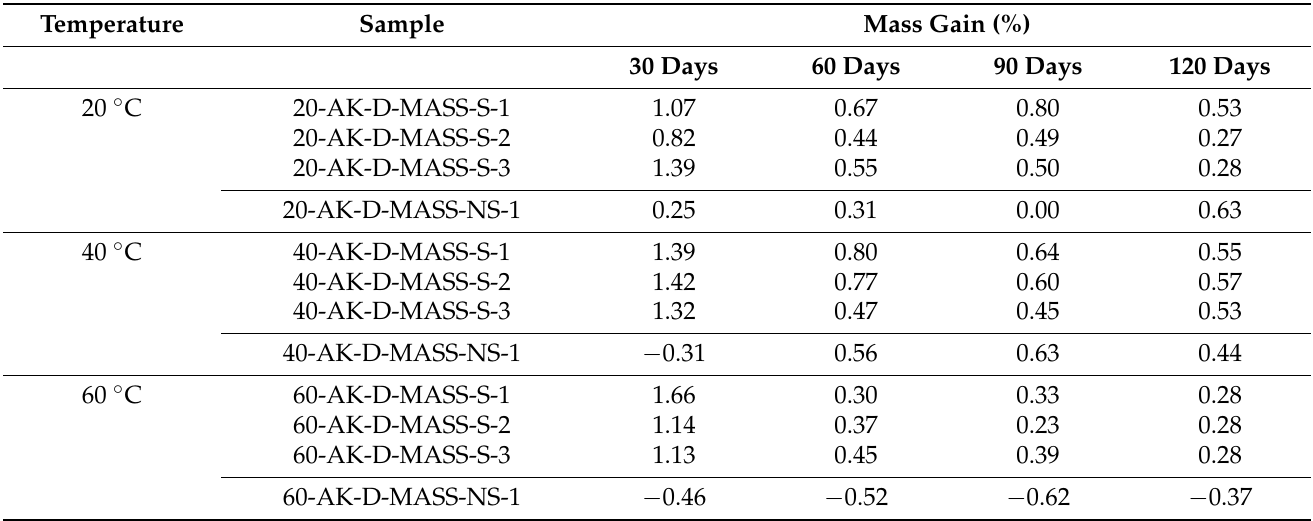
Table 3. Mass variations of GFRP rebars subjected to direct immersion in the alkaline solution. Temperature Sample Mass Gain